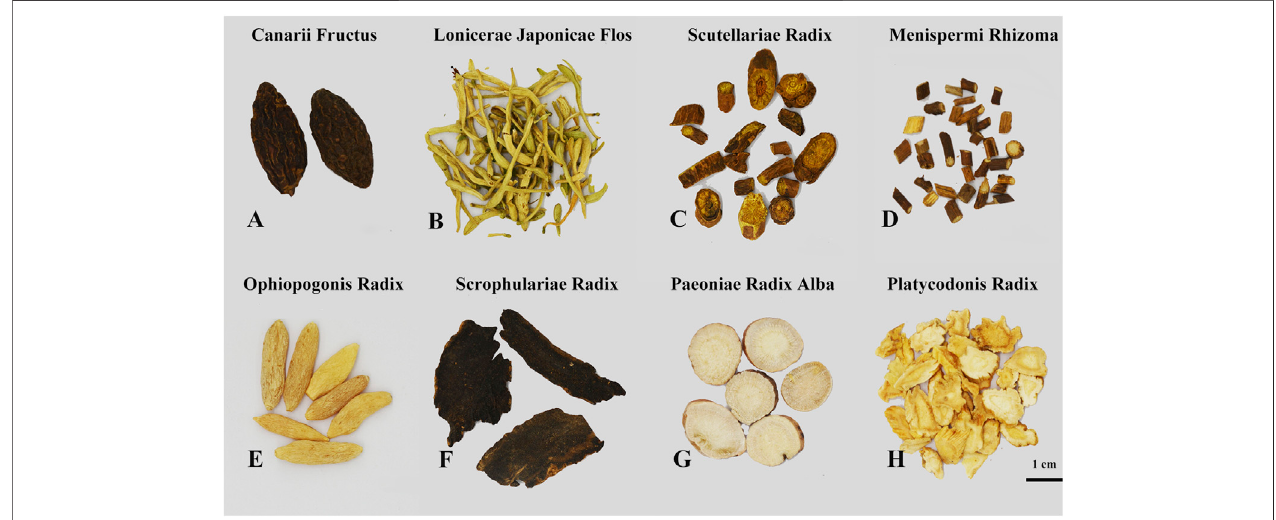
FIGURE 1 | The morphological characteristics of the eight herbal materials found in Qingguo Wan. (A) Canarii Fructus (Qingguo), (B) Lonicerae Japonicae Flos (Jinyinhua), (C) Scutellariae Radix (Huangqin), (D) Menispermi Rhizoma (Beidougen), (E) Ophiopogonis Radix (Maidong), (F) Scrophulariae Radix (Xuanshen), (G) Paeoniae Radix Alba (Baishao), and (H) Platycodonis Radix (Jiegeng).